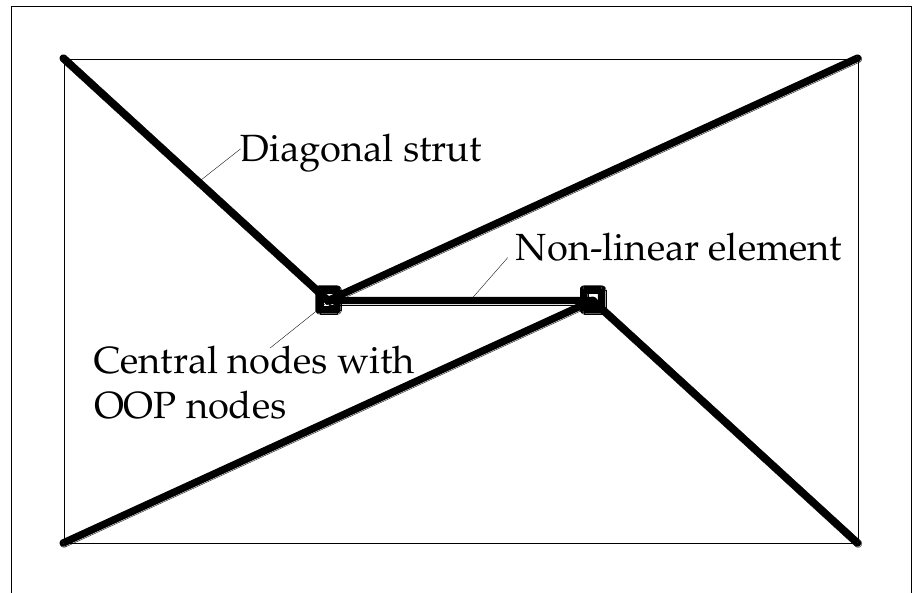
Figure 2. Simplified five-element model for infill walls.